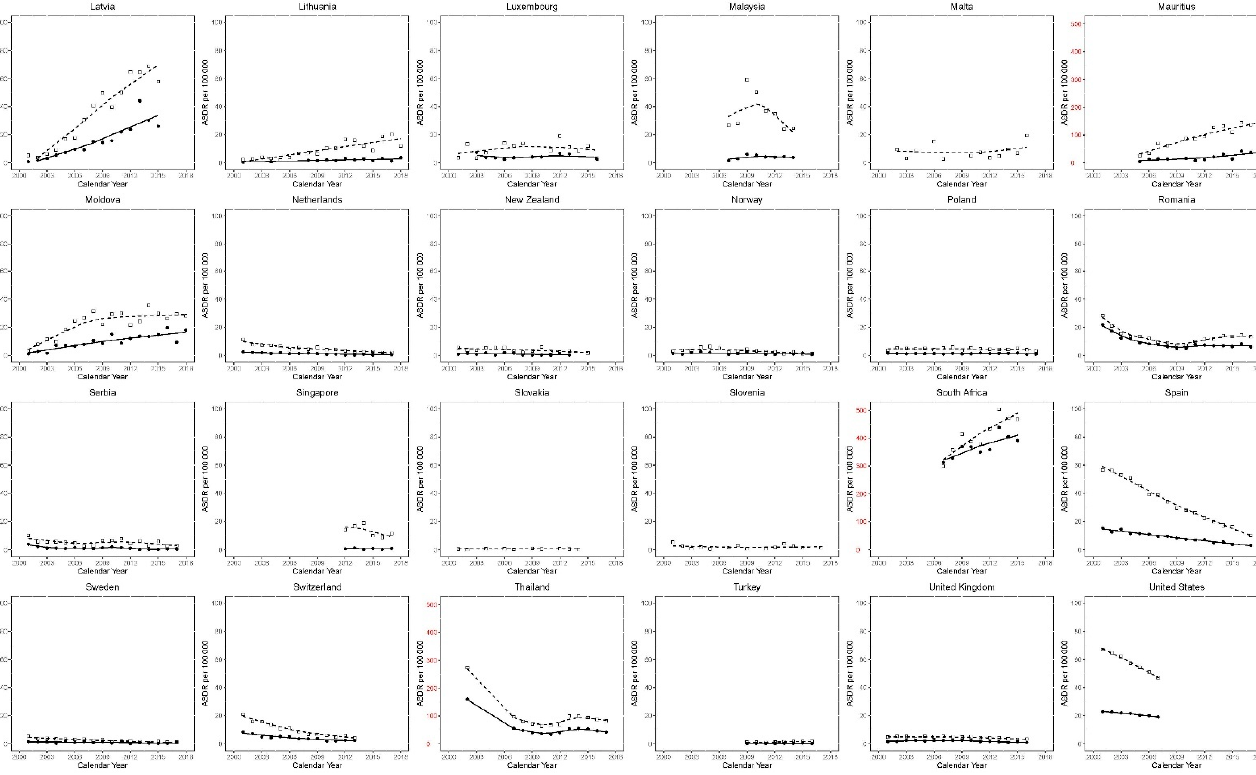
Figure 1. Trends in age-standardized death certification rates per 100,000 for HIV. Squares indicate male mortality, whereas circles indicate females.